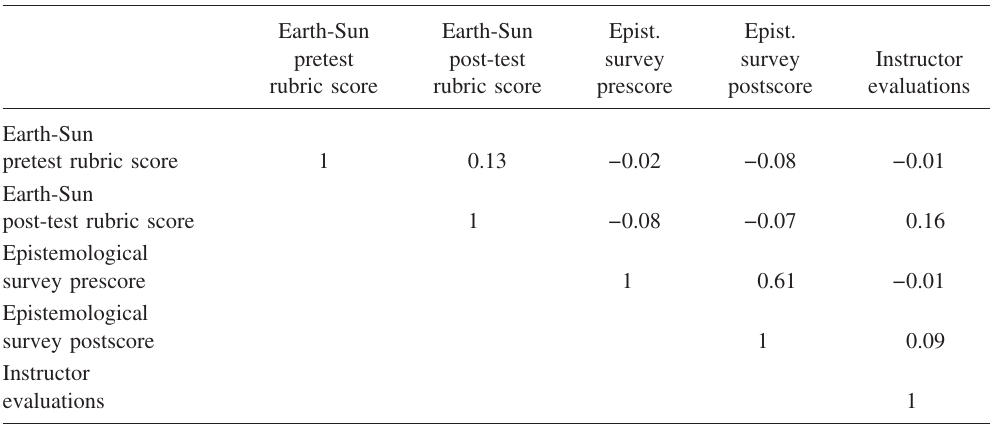
TABLE III. Correlation table among Earth-Sun pretest and post-test rubric score (cid:1) see Table I (cid:2) , epistemo- logical pre- and postscores (cid:1) See Fig. 3 (cid:2) , and instructor